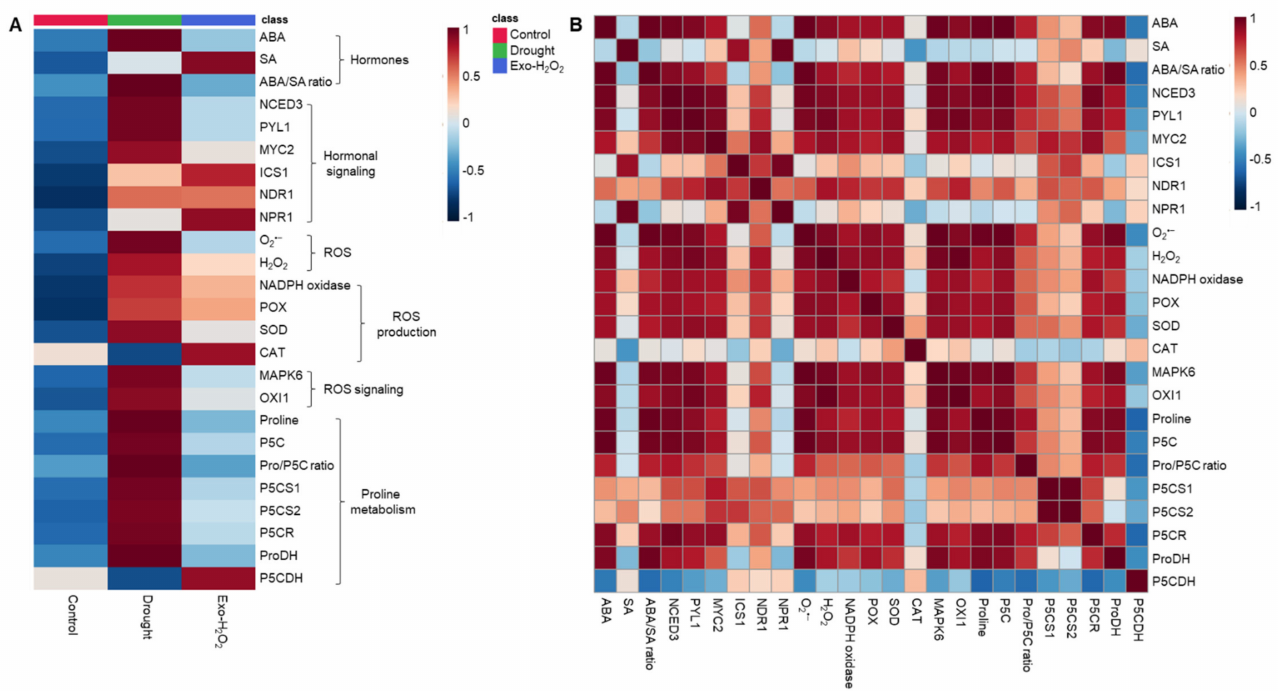
Figure 5. Heatmap analysis of the treatment effect and correlations among the variables measured for 10 days. ( A ) Heatmap comparing the changes of the identified metabolites or gene expression levels in the leaves of control, drought-, or exogenous H 2 O 2 (Exo-H 2 O 2 )-treated plants for 10 days. The normalization procedure consisted of mean row centering with color scales. ( B ) Heatmap showing the correlations among the identified metabolites or gene expression levels. Correlation coefficients were calculated based on Pearson’s correlation. Red indicates a positive effect, whereas blue indicates a negative effect. Color intensity is proportional to the correlation